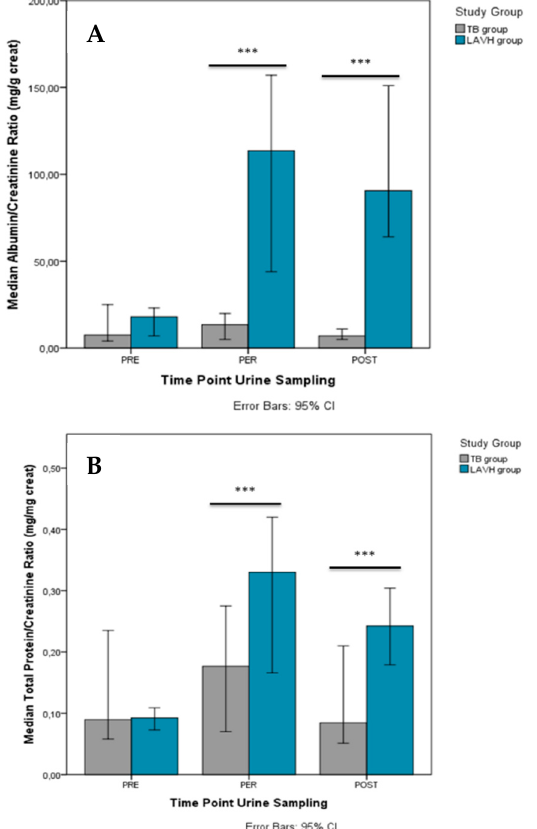
Figure 2. Comparison of the albumin/creatinine ratio ( A ) and total protein/creatinine ratio ( B ) between the TB and LAVH group PRE-, PER- and POST-intervention. Significant differences in the albumin/creatinine ratio and total protein/creatinine ratio between the groups were observed both PER- and POST-procedure. *** P -value < 0.001.